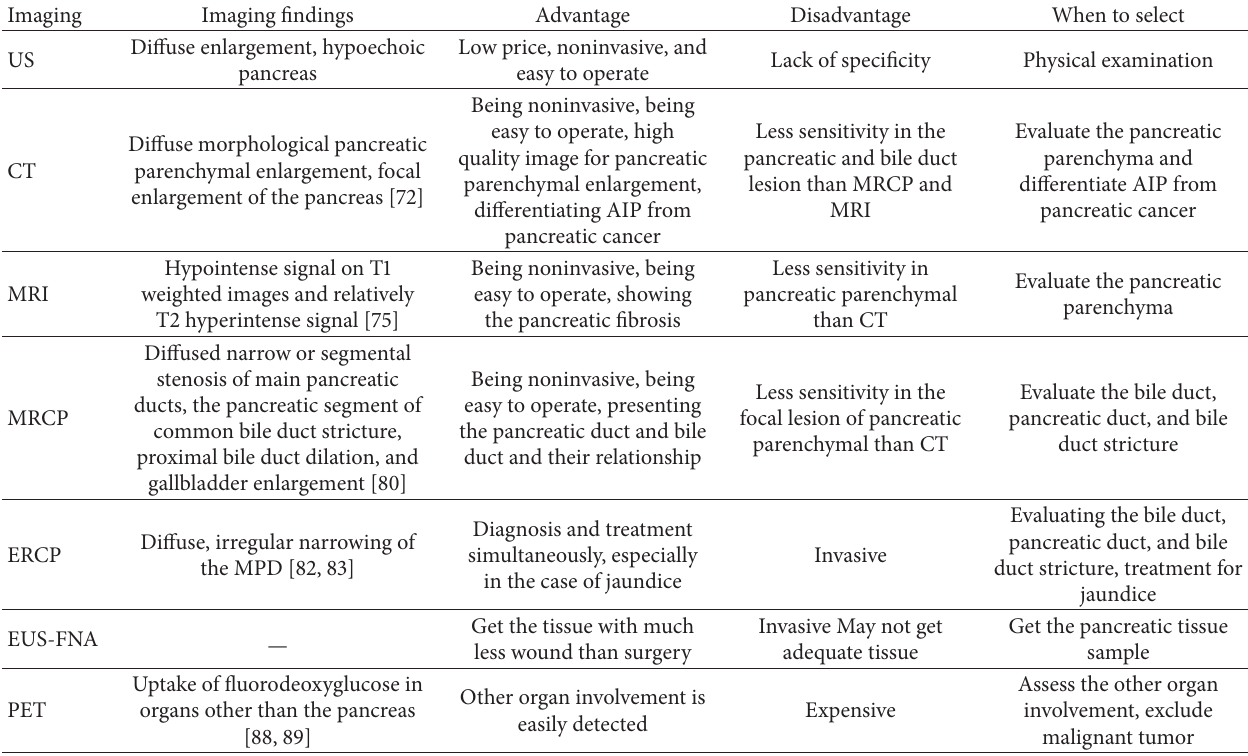
Table 5: Cons and pros of different kinds of